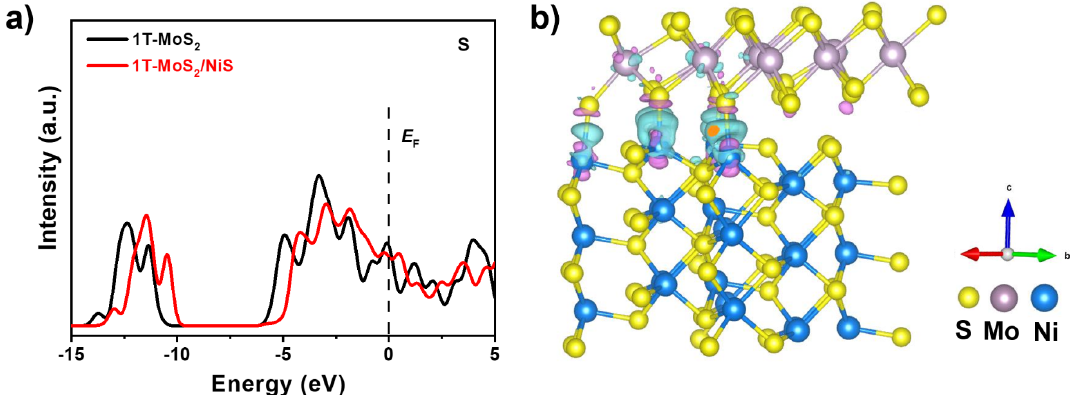
Figure 5. ( a ) Projected density of states (PDOS) of catalysts with the Fermi level set to zero. ( b ) the side view of the charge density distribution of 1T-MoS 2 /NiS, showing electron transfer from NiS to 1T-MoS 2 , with cyan and pink exhibiting the increase and decrease in electron density, respectively.